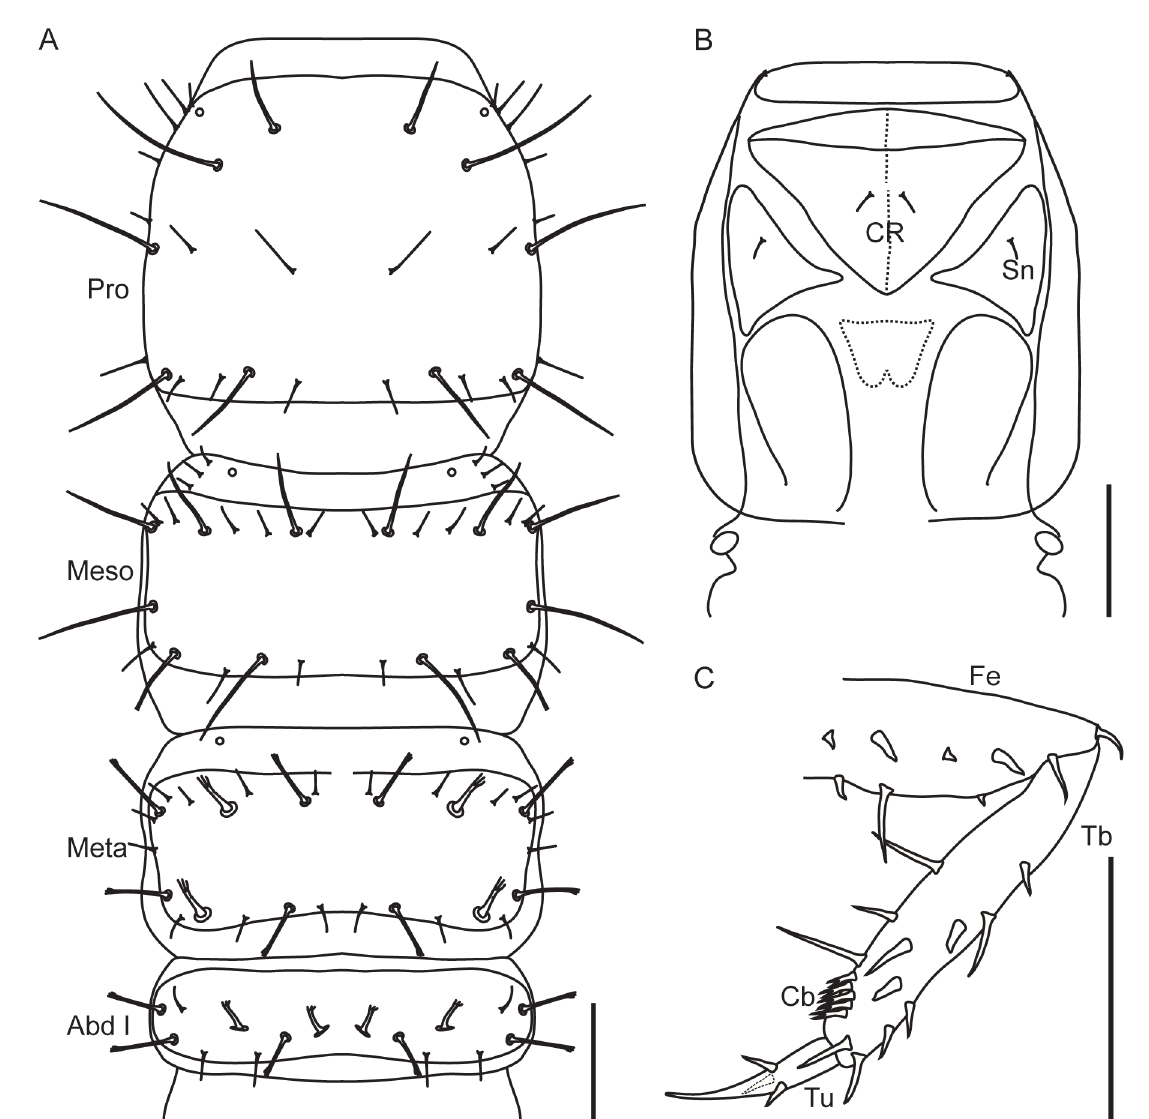
Fig. 7. Quedius masuzoi Watanabe, 1989. Morphology of larva: thorax and base of abdomen. A . Body fragment (thorax and abdominal segment I), dorsal view. B . Prothorax, ventral view. C . Anterior leg from anterior side. Abbreviations: Abd I = abdominal segment I; Cb = comb; CR = cervicosternum; Fe = femur; Meso = mesonotum; Meta = metanotum; Pro = pronotum; Sn = sternite of prosternal area; Tb = tibia; Tu = tarsungulus. Scale bars = 0.5